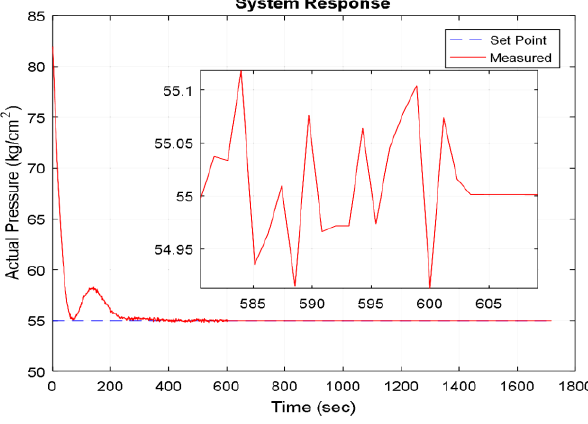
Fig. 9. Steam pressure response in tracking set-point